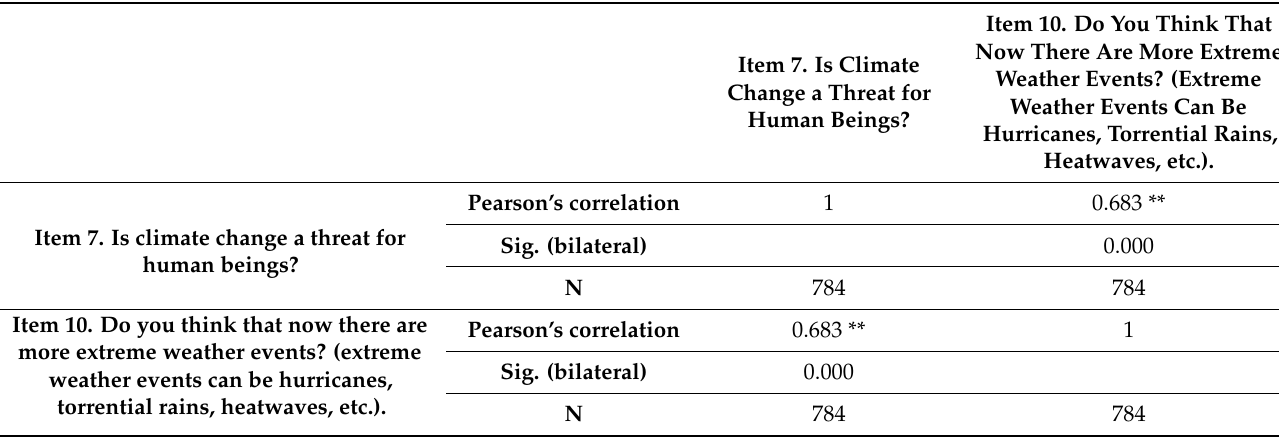
Table 5. Pearson’s correlations for the responses related to climate change (items 7 and